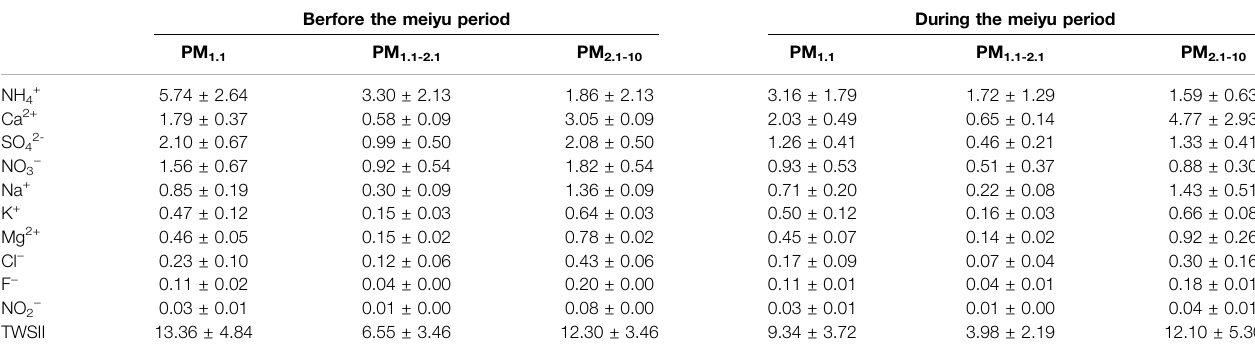
TABLE 3 | The average concentrations ( μ g/m 3 ) of WSII in particulate matters before and during the Meiyu period. Berfore the meiyu period During the meiyu period PM